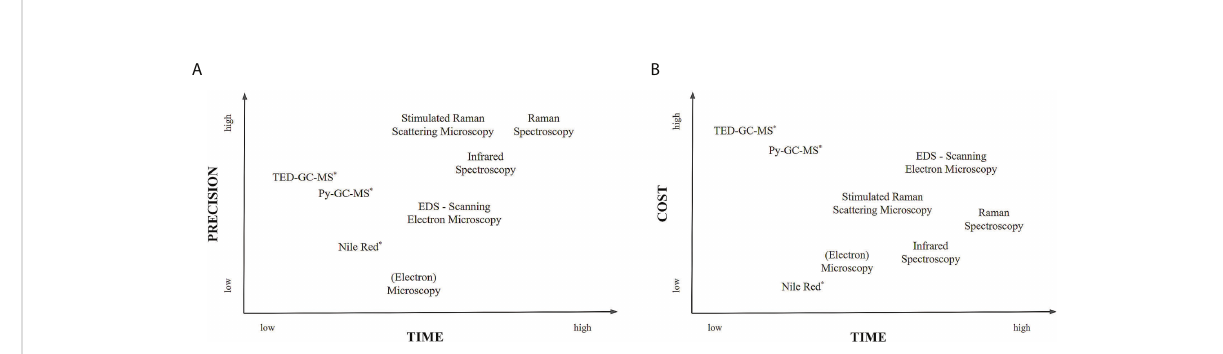
FIGURE 4 Identi fi cation and quanti fi cation techniques of microplastics based on precision/degree of detail, time and cost per sample to be analyzed. (A) A comparison between precision and time and (B) a comparison between cost and time. [The relative location of methods is based on literature data on required time for sample processing. Methods marked with an asterisk are destructive because they either pyrolyze the sample (Py-GC- MS, TDS-GC-MS) or stain the microplastic particles (Nile Red)]. [Modi fi ed from (Zar fl , 2019), (Primpke et al.,